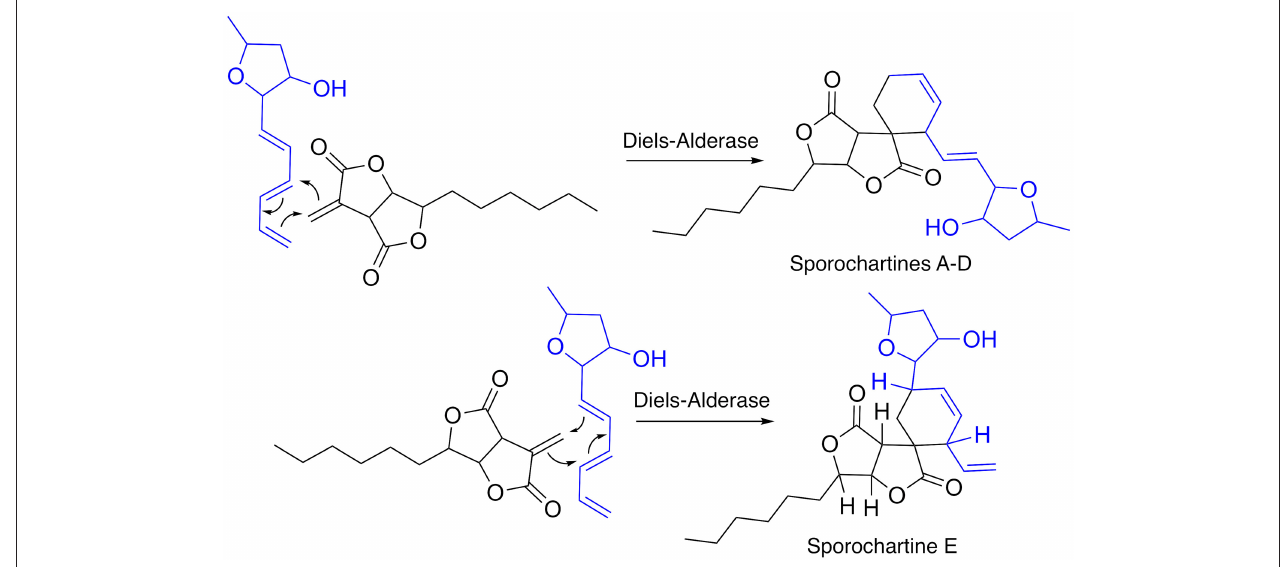
FIGURE 7 | Hypothetic biosynthesis of sporochartines through Diels-Alderase type reaction between sporothtriolide and trienylfuranol A.